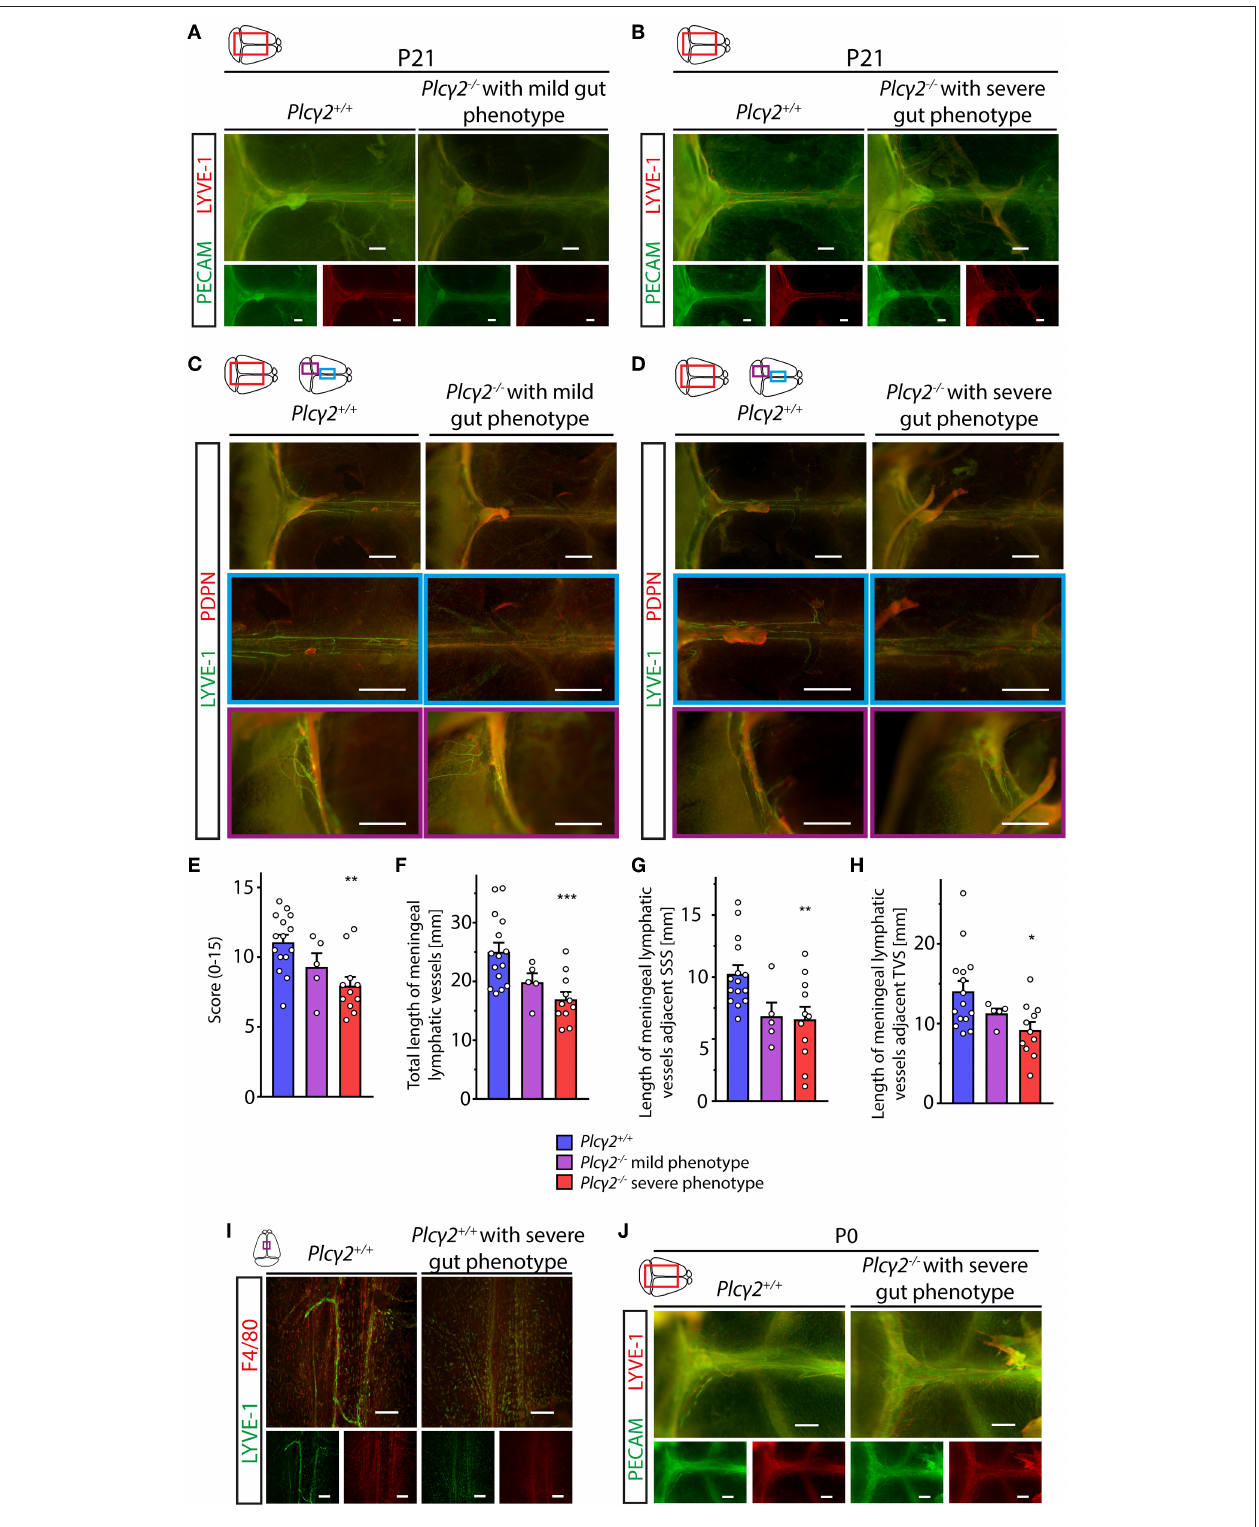
FIGURE 8 | Morphological characterization of the meningeal lymphatics in Plc γ 2 + / + and Plc γ 2 − / − mice. (A,B) Images are shown of PECAM and LYVE-1 expression in the meninges of young adult Plc γ 2 − / − and Plc γ 2 + / + mice with mild (A) or severe (B) gut phenotype ( n = 8 for Plc γ 2 + / + mice; n = 3 for Plc γ 2 − / − mice with